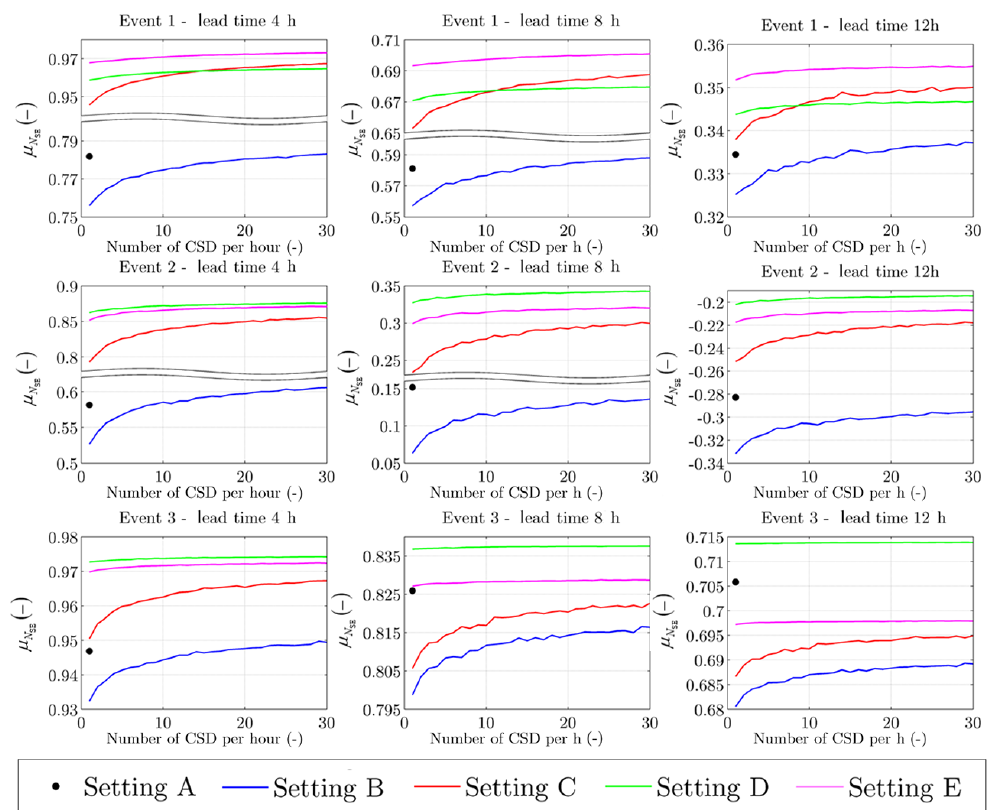
Figure 15. Model performance expressed as the mean of the Nash–Sutcliffe efficiency µ N crowdsourced data during the three considered flood events for the three lead time values (left panels: 4h; central panels: 8h; right panels: 12h) of scenario 10, for the five experimental settings (A to E) in the Bacchiglione